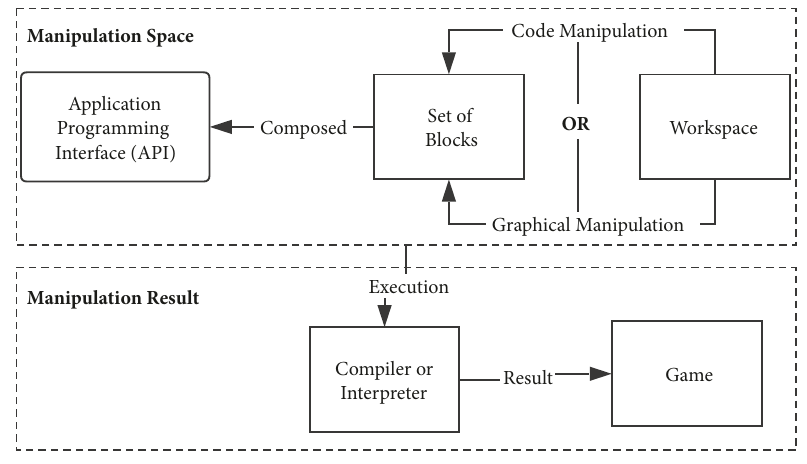
Figure 1: Abstract presentation of the adopted design for teaching computational